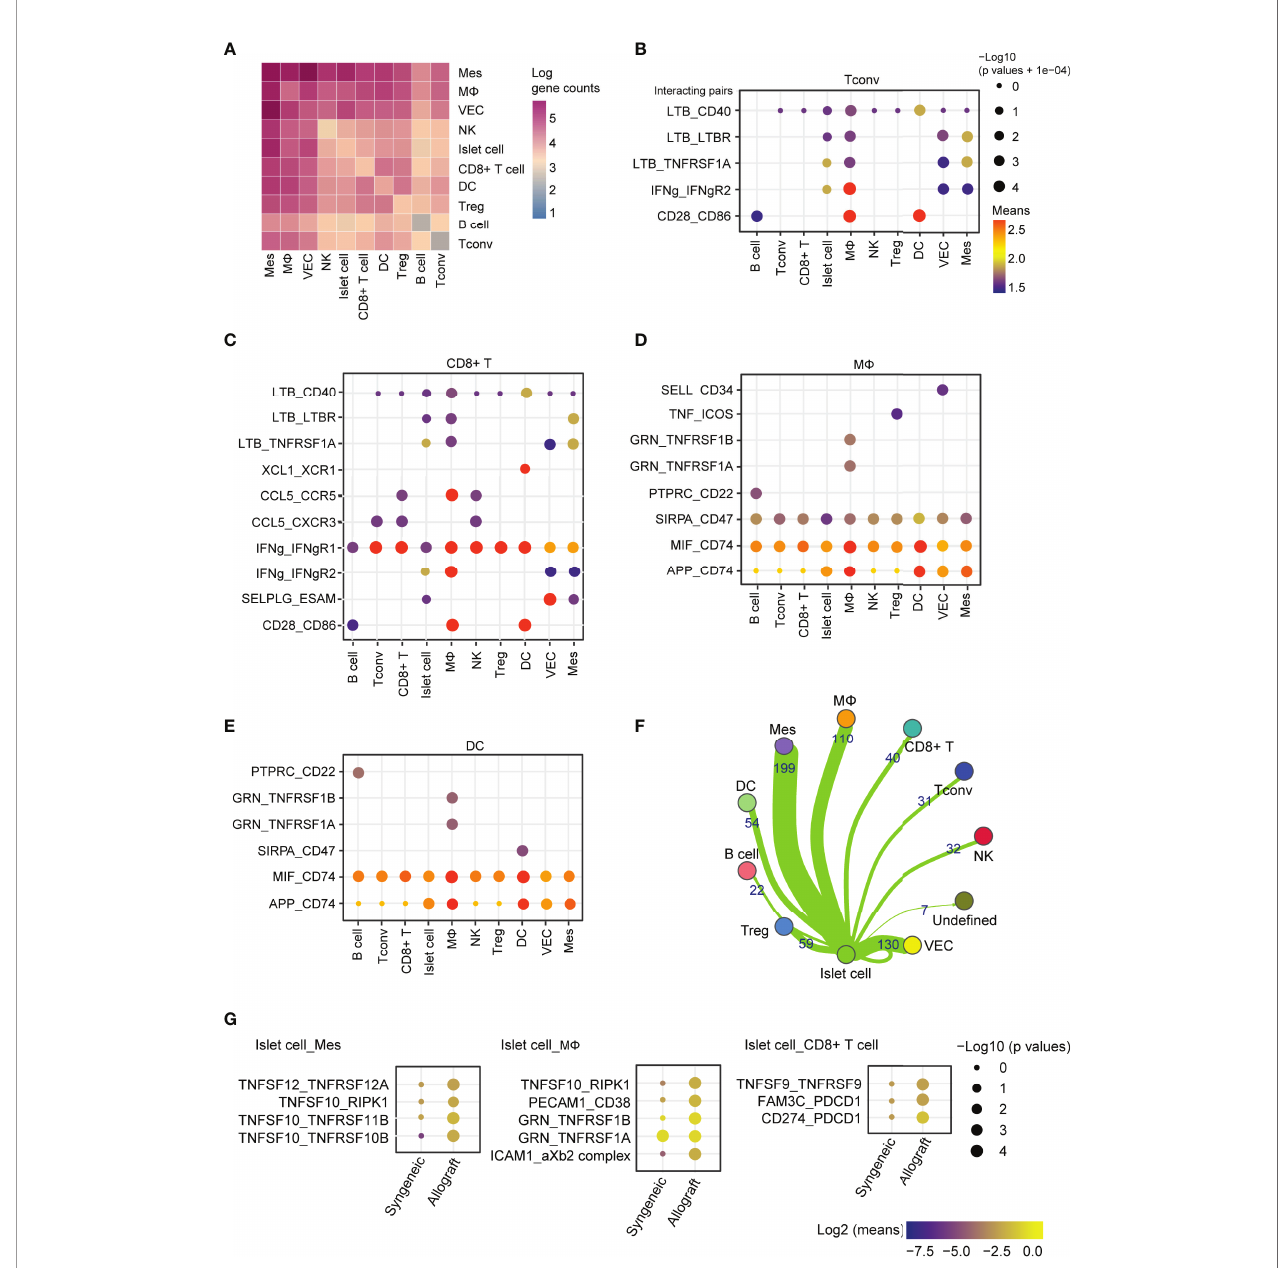
FIGURE 8 | Cell-cell communication between immune cells, mesenchymal cells, and islet cells in allografts. (A) Heatmap showing the log of the number of interacting gene pairs involved in cell-cell communications between every two cell types. (B – E) Dot plot showing ligand-receptor interactions of CD4 + T cells (B) , CD8 + T cells (C) , macrophages (D) , and dendritic cells (E) with other cell types. Color represents the means of the average gene expression level of interacting molecule one in cluster one and interacting molecule two in cluster two. Cell type labels were written as follows: cell type on the panel expressing the ligand and cell type below the panel expressing the receptor. (F) Network map showing cell-cell communications between islet cells and other cell types based on the number of genes involved. (G) Dot plot showing the ligand-receptor interaction of islet cell-expressing ligands and receptors expressed by mesenchymal cells, macrophages, and CD8 + T cells. Color represents the maximum normalized log2 mean interaction score in each cell-cell pair, and size indicates the log of p